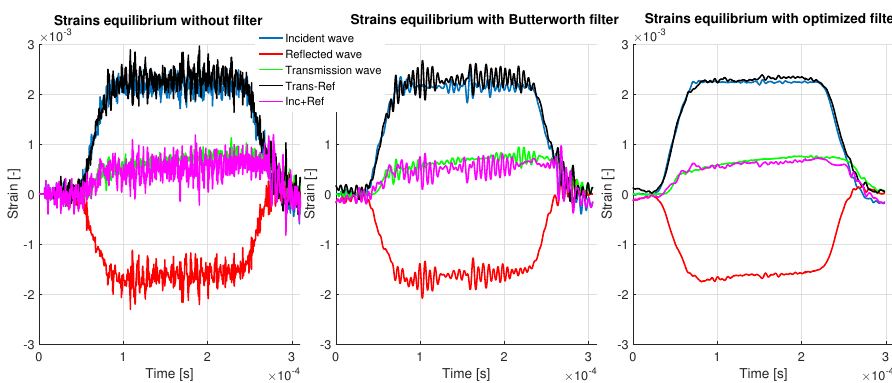
Figure 10. Comparison of strain equilibrium obtained without signal filtering and with two different filters: l s = 500 mm (long striker), v s = 24 . 05 ms − 1 (high striker